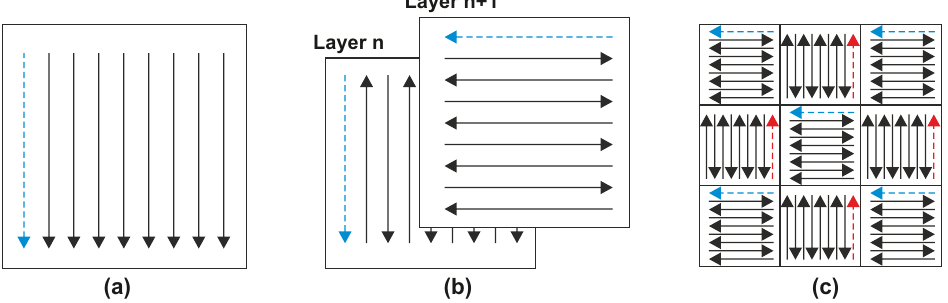
Figure 3. Scanning strategies ( a ) unidirectional, ( b ) stripe hatch with 90° rotation ( c )